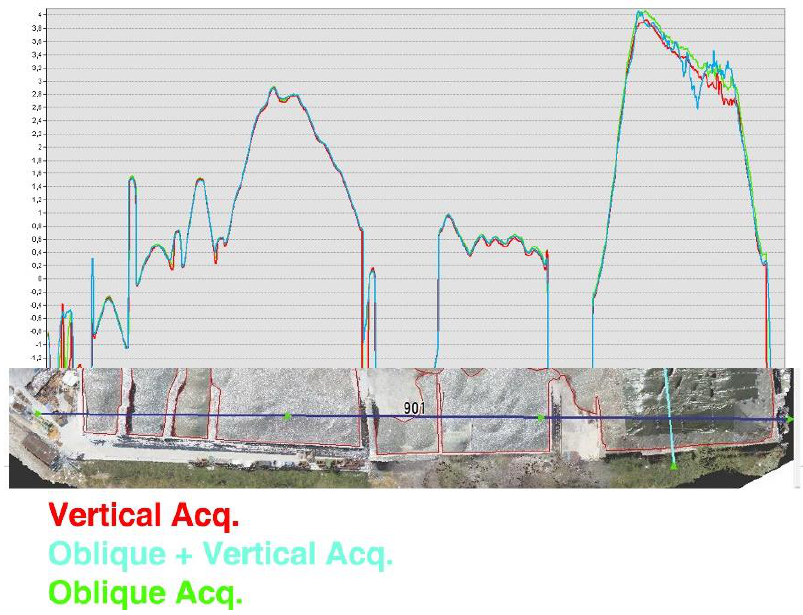
Figure 24. General photogrammetric DEM profiles.